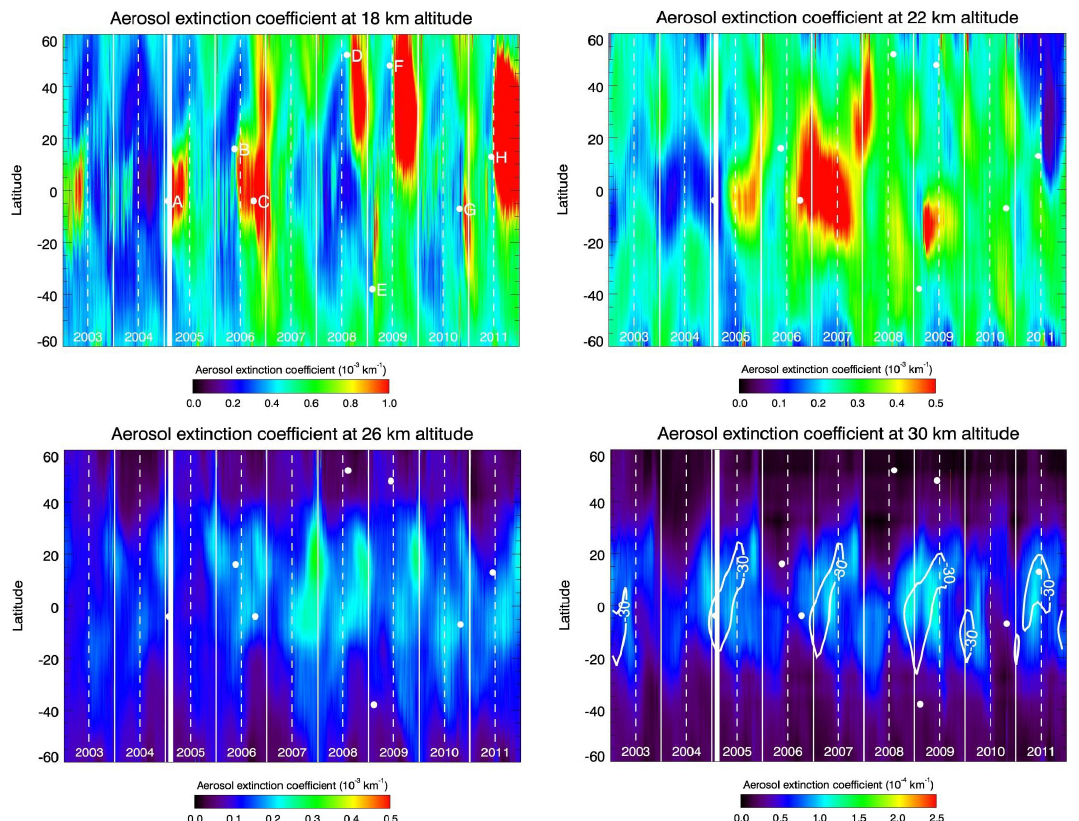
Figure 6. Aerosol extinction coefficient fields at 525nm wavelength as a function of time and latitude at 18km (top left panel), 22km (top right panel), 26km (bottom left panel) and 30km altitude (bottom right panel). The aerosol extinction profiles were daily and zonally averaged. The capital letters in the top left panel indicate volcanic eruptions (Manam: A, January 2005, 4 ◦ S; Soufriere Hills: B, May 2006, 16 ◦ N; Tavurvur: C, October 2006, 4 ◦ S; Kasatochi: D, August 2008, 52 ◦ N; Sarychev Peak: F, June 2009, 48 ◦ N; Mount Merapi: G, October 2010, 7 ◦ S; Nabro: H, June 2011, 13 ◦ N) and the Australian bush fires (E) of February 2009 at 38 ◦ S. The white stripe indicates a gap in the standard limb measurement coverage. The bottom right panel also shows the − 30ms − 1 contour line of the monthly and zonally averaged zonal wind at the 10hPa level taken from ERA